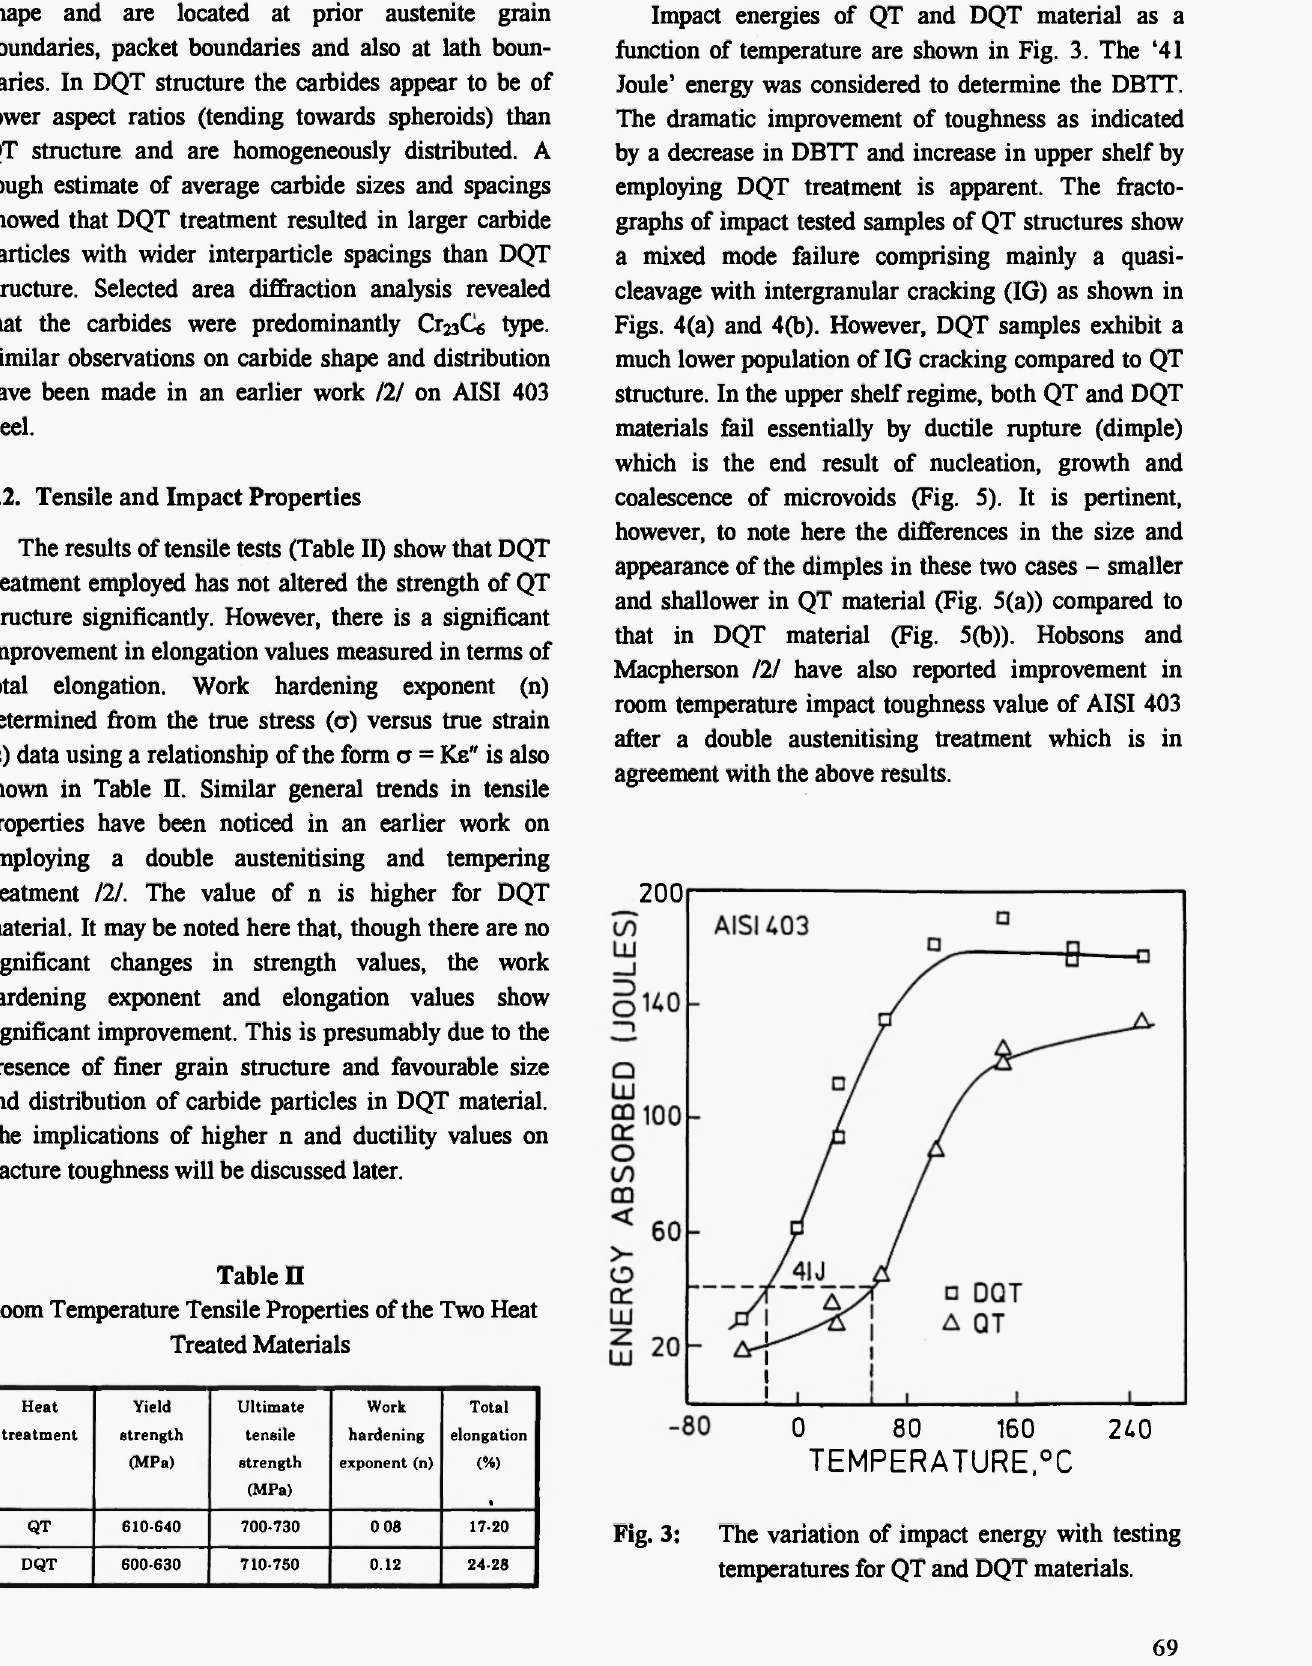
The variation of impact energy with testing temperatures for QT and DQT